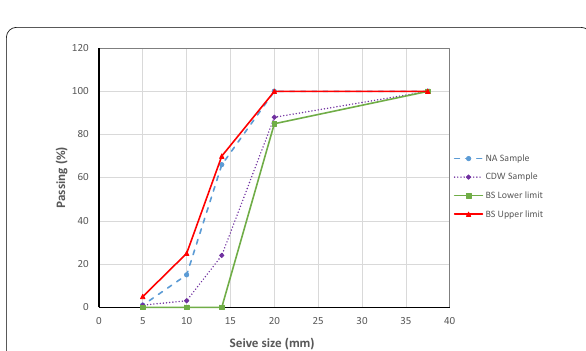
Fig. 2 Grading of the normal and recycled